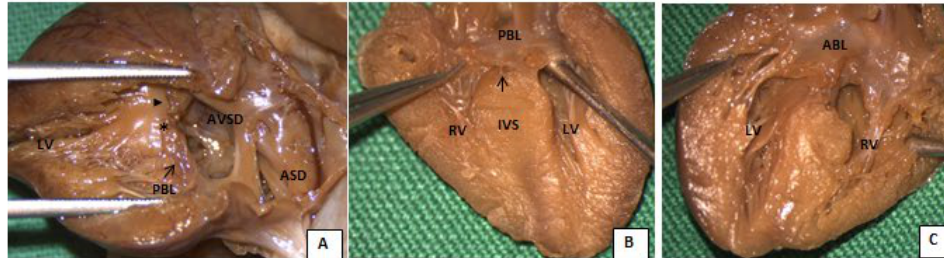
Figure 2. Female fetus heart at 20 weeks of gestation, affected by trisomy 21 and volunteer pregnancy interruption. ( A ) Macroscopic view of the left cavities mimicking the lateral long axis two-chamber echo view; note the patent oval fossa and complete atrioventricular septal defect with a common orifice of the valve with the posterior bridging leaflet (PBL, arrow) and anterior bridging leaflet (head arrow) and the gap between the two (*). Four-chamber section at the level of the gap at the interventricular septum between the anterior and posterior bridging leaflets. Posterior view ( B ) showing the posterior bridging leaflet attached to the interventricular septum (arrow), with the intact free margin of the posterior leaflet confirming the absence of the fusion with the anterior leaflet. Anterior view of the four-chamber section with the anterior leaflet attached to the interventricular septum (type A of Rastelli) ( C ).